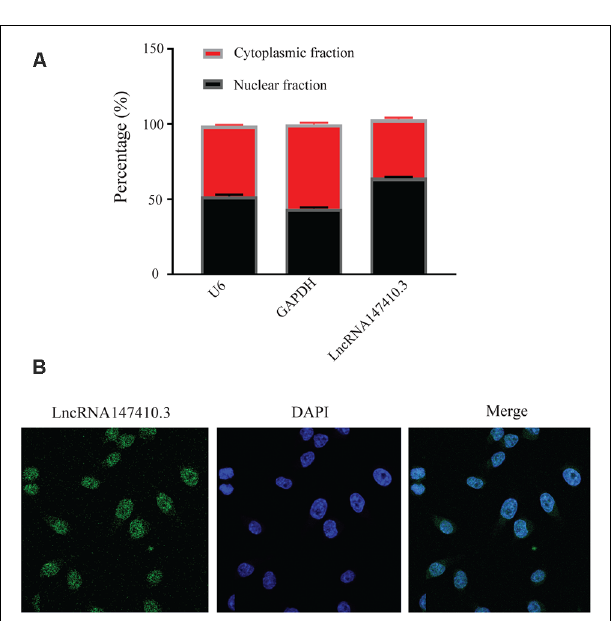
FIGURE 4 | Localization of lncRNA147410.3 in BV-2 cells. (A) Nuclear cytoplasmic expression of lncRNA147410.3 in BV-2 cells was detected by qRT-PCR. (B) The localization of lncRNA147410.3 in BV-2 cells was detected by FISH assay. labeled apoptotic cells were increased significantly compared with the control group, while the fluorescent apoptotic cells in the interference group decreased ( Figure 6 ). Thus, the results indicated that overexpression of lncRNA147410.3